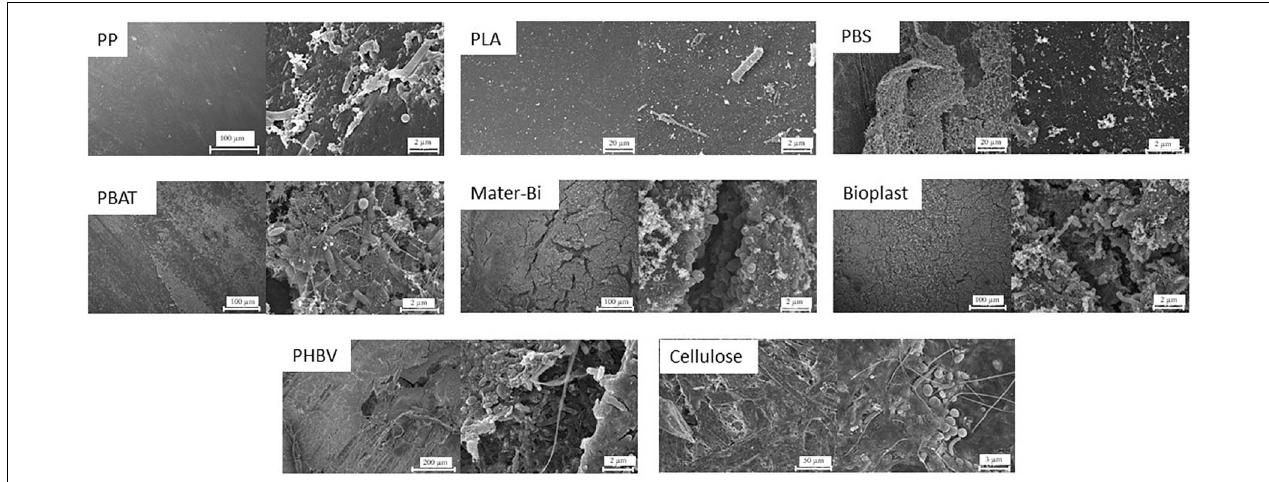
FIGURE 1 | Scanning electron microscopy of the eight polymer types (PP, PLA, PBS, PBAT, Bioplast, Mater-Bi, PHBV, and cellulose) showing the diversity of morphologies and abundance of bacteria cell-likes structures after 40 days in natural seawater followed by 94 days in minimum medium (D40 + 94). PP, polypropylene; PLA, polylactic acid; PBS, poly(butylene succinate); PBAT, polybutylene adipate terephthalate; PHBV, polyhydroxybutyrate-valerate.